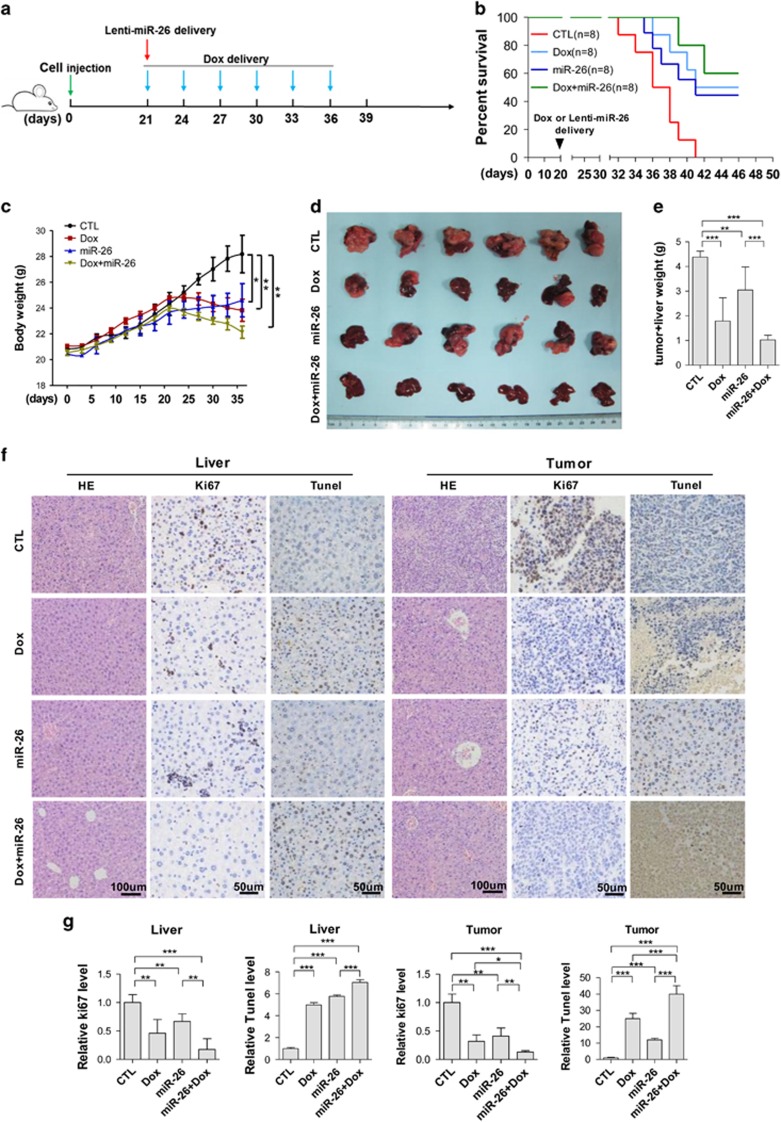
Intravenous injections of miR-26a/b-expressing lentivirus enhance the efficiency of chemotherapeutic drugs by blocking the growth of tumor in vivo. (a) A schematic diagram illustrating the experimental design. The HCC mouse model was constructed using HepG2 cells. Intravenous delivery of miR-26a/b-expressing lentivirus started at 3 weeks after orthotopic liver implantation in nude mice (day 0). Then, mice were administered with PBS or Dox every 3 days. Mice were divided into four groups according to the treatments: PBS (CTL), Lenti-miR-26 (miR-26), Dox and Dox plus Lenti-miR-26 (DOX+miR-26). (b) Survival analysis. (c)The time course of body weight. (d) Tumors at the week 5. (e) The quantitative analysis of tumor and liver weights. (f) HE, Ki67 and Tunel staining of tumor and liver sections obtained from the four mouse groups. (g) The histograms represent quantitative analyses of Ki67 and Tunel-positive signals in the tumor and liver sections. All data are shown as the means±S.E. obtained from three separate experiments. *P<0.05; **P<0.01; and ***P<0.001